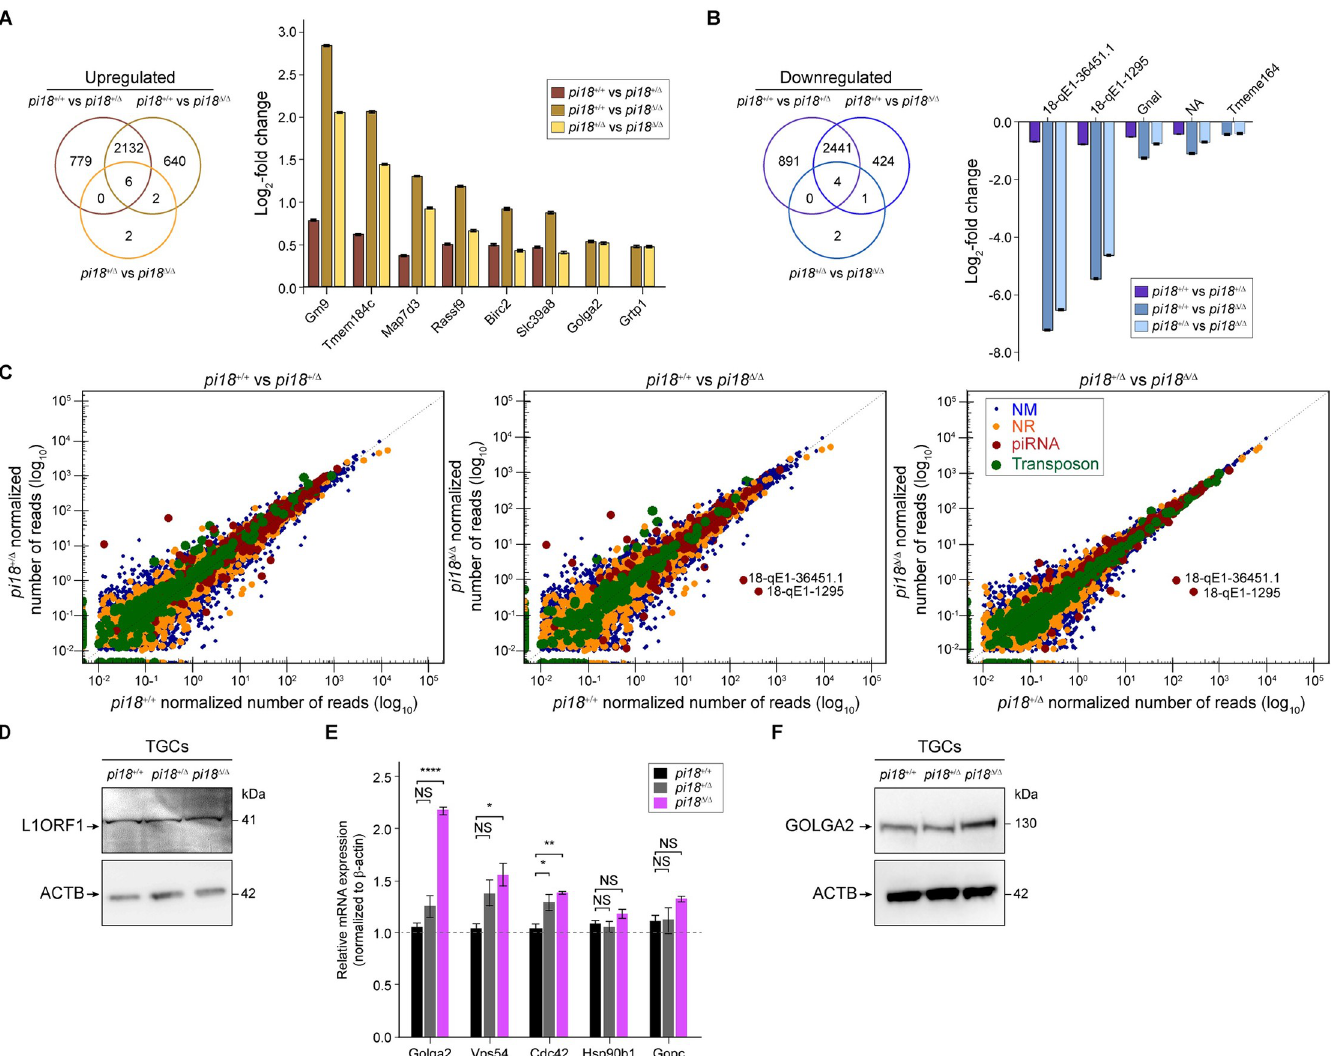
Fig 5. Altered abundance of Golga2 in pi18 Δ / Δ mice. (A) Venn diagrams depicting the overlap of up-regulated (left) in wild-type (+/+) vs heterozygous (+/ Δ ), wild- type (+/+) vs homozygous ( Δ / Δ ), and heterozygous (+/ Δ ) vs homozygous ( Δ / Δ ) of RNA-seq data from pi18 +/+ , pi18 +/ Δ , and pi18 Δ / Δ testes ( n = 3 for each genotype) at P28 using adjusted P < 0.01 as the cut off. Up-regulated (log 2 -fold change) in Venn diagrams (right). (B) Same as (A), but for down-regulated genes (left) and down- regulated (log 2 -fold change) in Venn diagrams (right). (C) Scatter plots comparing +/+ to +/ Δ (left), +/+ to Δ / Δ (middle) and +/ Δ to Δ / Δ (right) of RNA-seq reads assigned to mRNA (NM, blue); non-coding RNA (NR, orange); piRNA (red); transposons (green). (D) Immunoblot of L1ORF1 in testicular germ cells (TGCs) from pi18 +/+ , pi18 +/ Δ , and pi18 Δ / Δ ( n = 3 for each genotype). Actin is used as a load control. Image is representative of three independent experiments. (E) Quantitative RT-PCR validation of up-regulated genes related to acrosome biogenesis using β -actin transcript as an internal control ( n = 3 per genotype). Data are shown as mean ± s.d. Results shown reflect three independent experiments. (F) Same as (D), but for GOLGA2. NS, not significant, � P < 0.05, �� P < 0.01, and ���� P < 0.0001.